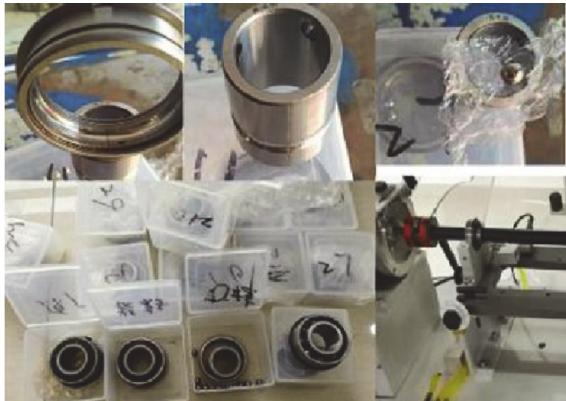
Figure 6: SER205 fault